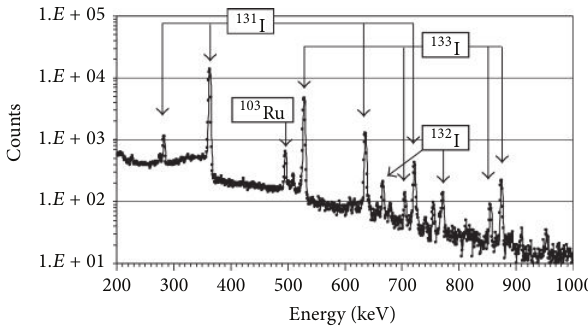
Figure 4: Gamma spectrum of the Ag-coated Al 2 O 3 column after passing the filtrated target solution. The measurement was done from large distance. Only gamma signals from iodine radionuclides and Ru could be identified.